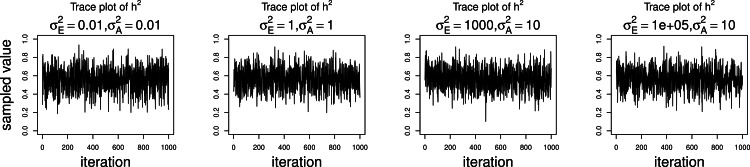
Trace plots of heritability.Chains for various starting values, for the scenario with h2 = 0.60 using the WaNPRC pedigree. The values of \documentclass[12pt]{minimal}
\usepackage{amsmath}
\usepackage{wasysym} 
\usepackage{amsfonts} 
\usepackage{amssymb} 
\usepackage{amsbsy}
\usepackage{upgreek}
\usepackage{mathrsfs}
\setlength{\oddsidemargin}{-69pt}
\begin{document}
}{}${\sigma }_{E}^{2}$\end{document}σE2 and \documentclass[12pt]{minimal}
\usepackage{amsmath}
\usepackage{wasysym} 
\usepackage{amsfonts} 
\usepackage{amssymb} 
\usepackage{amsbsy}
\usepackage{upgreek}
\usepackage{mathrsfs}
\setlength{\oddsidemargin}{-69pt}
\begin{document}
}{}${\sigma }_{A}^{2}$\end{document}σA2 above each panel represent the starting values for the MCMC chain. Iterations were thinned at every 1000.